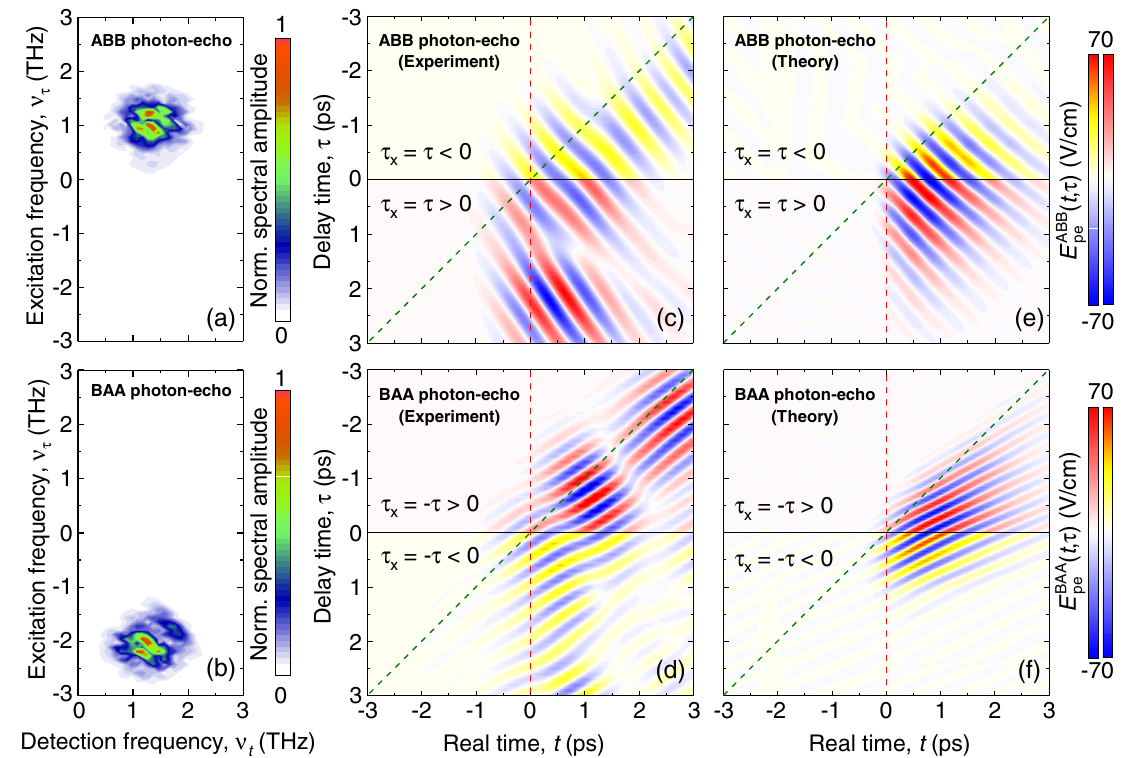
FIG. 7. The 2D-filtered photon-echo signals. (a) ABB photon echo [red circle in Fig. 4(c)] and (b) BAA photon echo [blue circle in ð t; τ Þ and E BAA ð t; τ Þ , respectively. (e,f) Corresponding theoretical Fig. 4(c)]. (c,d) Contour plots of the Fourier-back-transformed E ABB pe pe 2D plots. The green and red dashed lines indicate the position of the driving fields A and B, respectively, while the black line indicates τ ¼ 0 ps. The contour plots are color-coded differently in order to distinctly separate the nonlinear contributions at positive and negative coherence times τ x